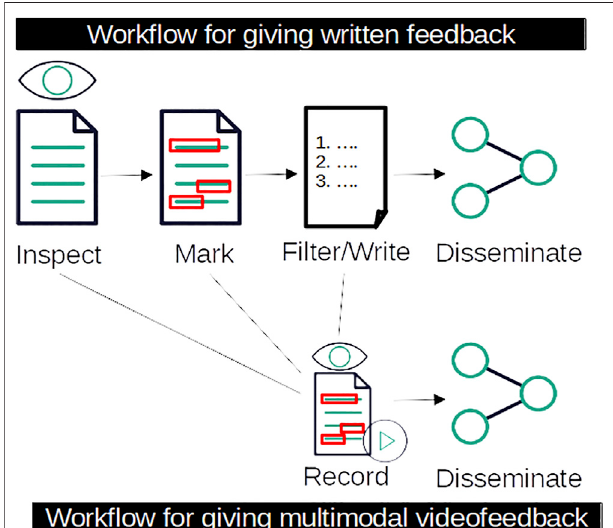
FIGURE 1 | Process work fl ow of video-feedback compared to textual